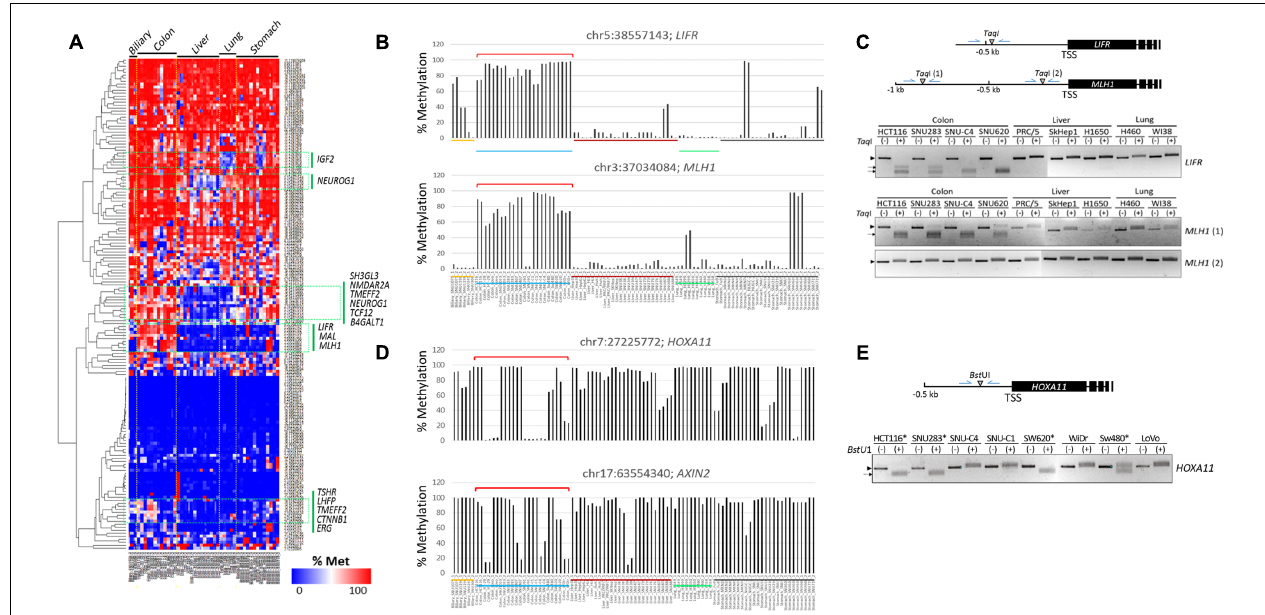
FIGURE 3 | Identification of CpG sites specifically methylated in colon cancer cell lines. (A) Heat map of the methylation levels of target CpGs. Target CpGs that are differentially methylated among the cell lines are indicated by green boxes with the associated gene symbols. Methylation levels of the LIFR and MLH1 (B) and HOXA11 and AXIN2 (D) CpG sites in colon cancer cell lines. Chromosomal locations of target CpG sites are represented as the chromosome (chr) number and coordinate of the position of cytosine. Cell lines of different cancer groups are indicated in different colors below: biliary tract, colon, liver, lung, and stomach cancer cell lines are yellow, blue, dark red, green, and black, respectively. Brackets (red) denote colon cancer cell lines showing differential methylation patterns. (C,E) Combined bisulfite restriction analysis (COBRA). Schematics show the relative positions of the transcription start sites (TSSs) of target genes and the restriction enzyme ( Taq I or Bst UI) site. Genomic DNA was treated with bisulfite to convert unmethylated cytosines to uracils, which are then amplified as thymines, and then used as a template in PCR. The PCR products were digested with the indicated restriction enzyme. If the region of interest were methylated, the PCR product would be digested. In (E) , only colon cancer cell lines were included, and HOXA11 promoter-methylated cell lines are indicated by asterisks. Arrow heads and arrows indicate the band positions of intact and enzyme-digested PCR products,